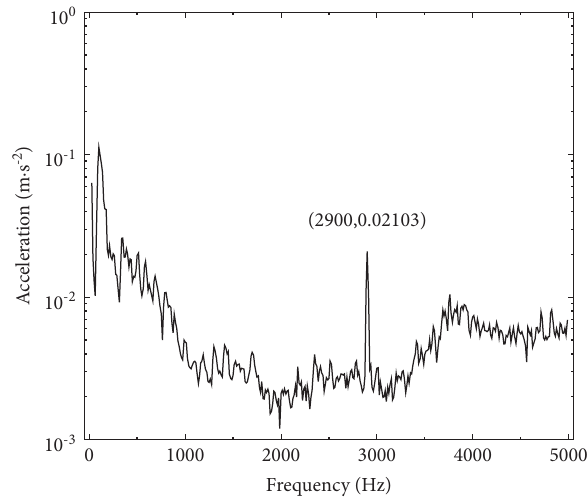
Figure 16: Radial vibration response of the busbar shell in the